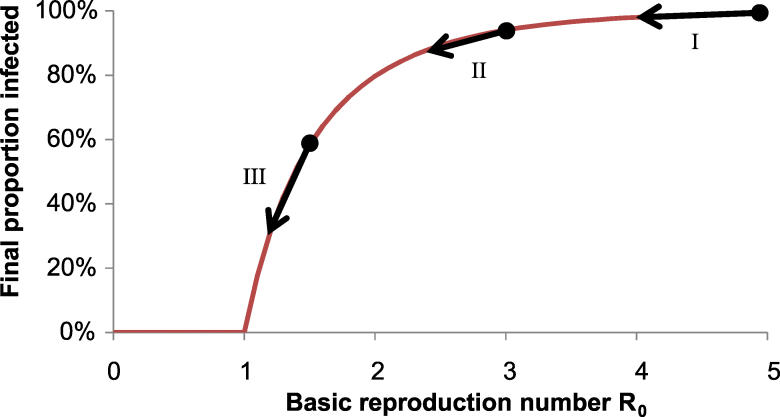
How the Efficacy of Interventions That Limit Transmission Depends on the Basic Reproduction Number, R
0
The final proportion infected in a pandemic for a general class of models with homogeneous population mixing is plotted as a function of R
0 [22,23]. The arrows highlight the effect of an intervention that reduces transmission by 20% for three different baseline values of R
0. This curve can be used, for example, to predict the effect of a vaccine that directly protects 20% of individuals on those who are not directly protected. In scenario I, R
0 is 5 and the intervention reduces the attack rate by 1.3%. In scenario II, R
0 is 3 and the reduction is 6.2%. In scenario III, R
0 is 1.5 and the reduction is 26.9%